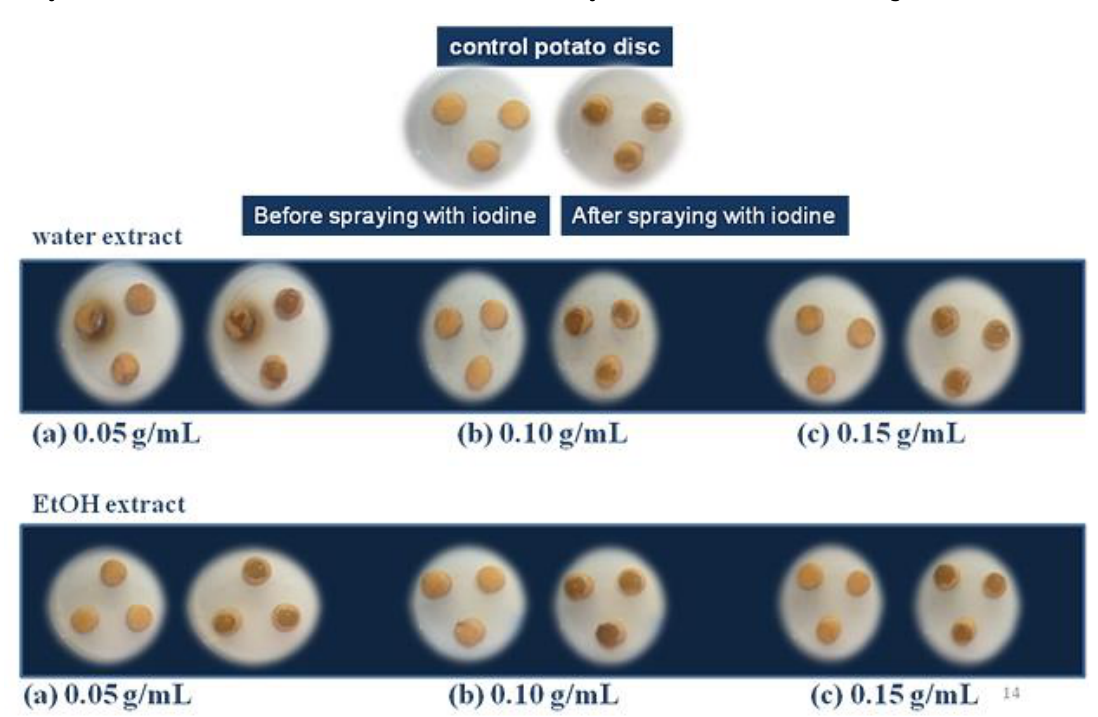
Figure 2. Observation of tumor inhibition of ethanol and watery extract of stem bark of P.albizzioides (6) Inhibition of NO production against LPS induced RAW264.7 cells